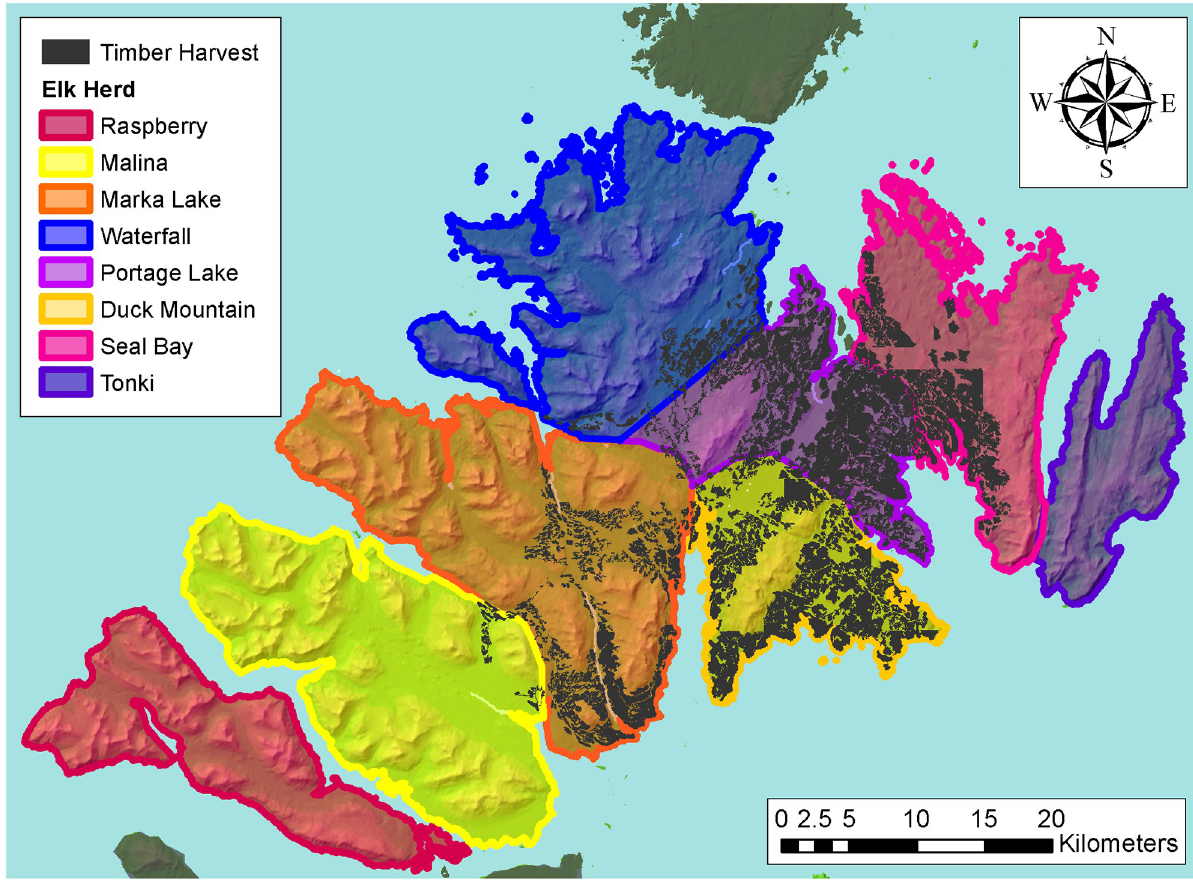
Fig 2. Area of timber harvest and locations of elk herds, Afognak and Raspberry islands, Alaska, USA. Background terrain map from Alaska Department of Fish and Game Wildlife Division Staff.